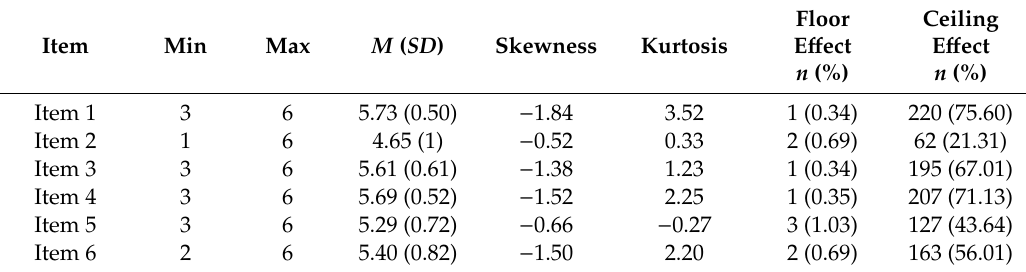
Table 1. Performance of Health Professionals Communication Skills Scale (HP-CSS) and related normative